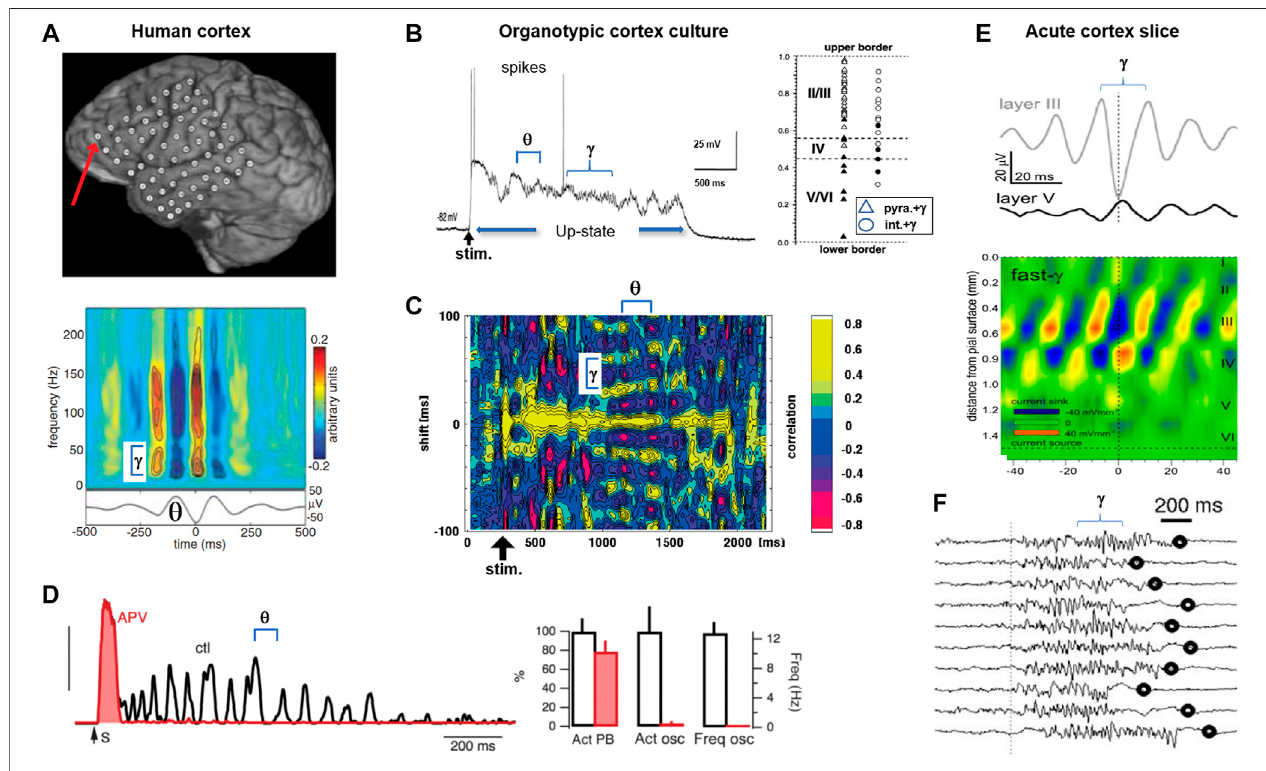
FIGURE 2 | The fi rst and second dynamical motif of dynamical self-organization: up-state and nested θ / γ -oscillations in organotypic cortex cultures and acute cortex slices. (A) The human brain displaying distinct periods of nested θ / γ -oscillations at rest and during behavior. Top : electrode array on the cortex surface ( circles ) recordingtheelectrocorticogram. Bottom :correspondingpowerspectrumoffast γ -oscillations( > 25 Hz; top )phaselockedoverseveralcyclesofa θ -oscillation( bottom ) (reprinted with permission from [34]). (B) In mature organotypic cortex cultures, neuronal activity self-organizes into up-states with nested θ / γ -oscillations in super fi ciallayers. Left :timecourseoftheintracellularmembranepotentialforapyramidalneuroninresponsetoamicrosecond-lasting,electricalshockstimulation( stim ; arrow ).Note self-sustainedup-state withnested θ / γ -oscillations and sparseoccurrenceofaction potentials ( spikes ). Right : γ -oscillations arefoundinpyramidalneurons ( triangles )andinterneurons( circles )ofsuper fi cial( open ),butnotdeeplayers( fi lled ). (C) Crosscorrelationovertimeinthemembranepotentialoftwopyramidalneuronsin response to electrical shock stimulation ( stim ; arrow ). Note maintained phase locking of nested θ / γ -oscillations during the up-state with drop in γ -frequency creating a fan-out pattern (subpanels B and C modi fi ed from [39]). (D) Self-sustained up-states with θ -oscillations require recurrent, excitatory network connections. Blocking the excitatoryNMDAglutamatereceptorwiththeantagonistAPVonlyleavesaninitial,short-lastingdirectresponse(organotypiccortexculture)( red ). Left :populationactivity time course to electric shock stimulation ( S ; arrow). ctl : control. Right : APV only slightly reduces the number of up-states ( leftmost bars ) but blocks the emergence of oscillations at θ -frequency ( middle and rightmost bars ). Act : control (reprinted with permission from [42]). (E) In the acute cortex slice, γ -oscillations emerge in super fi cial layers(CSDanalysis)(reprinted withpermission from [63]). (F) Acutecortexslicefrom adultferretwithspontaneous,self-sustainedperiod offast γ -oscillationsintheLFP (reprinted with permission from [43]; Copyright 2008 Society for Neuroscience). Oscillation identi fi ers have been added to some subpanels for